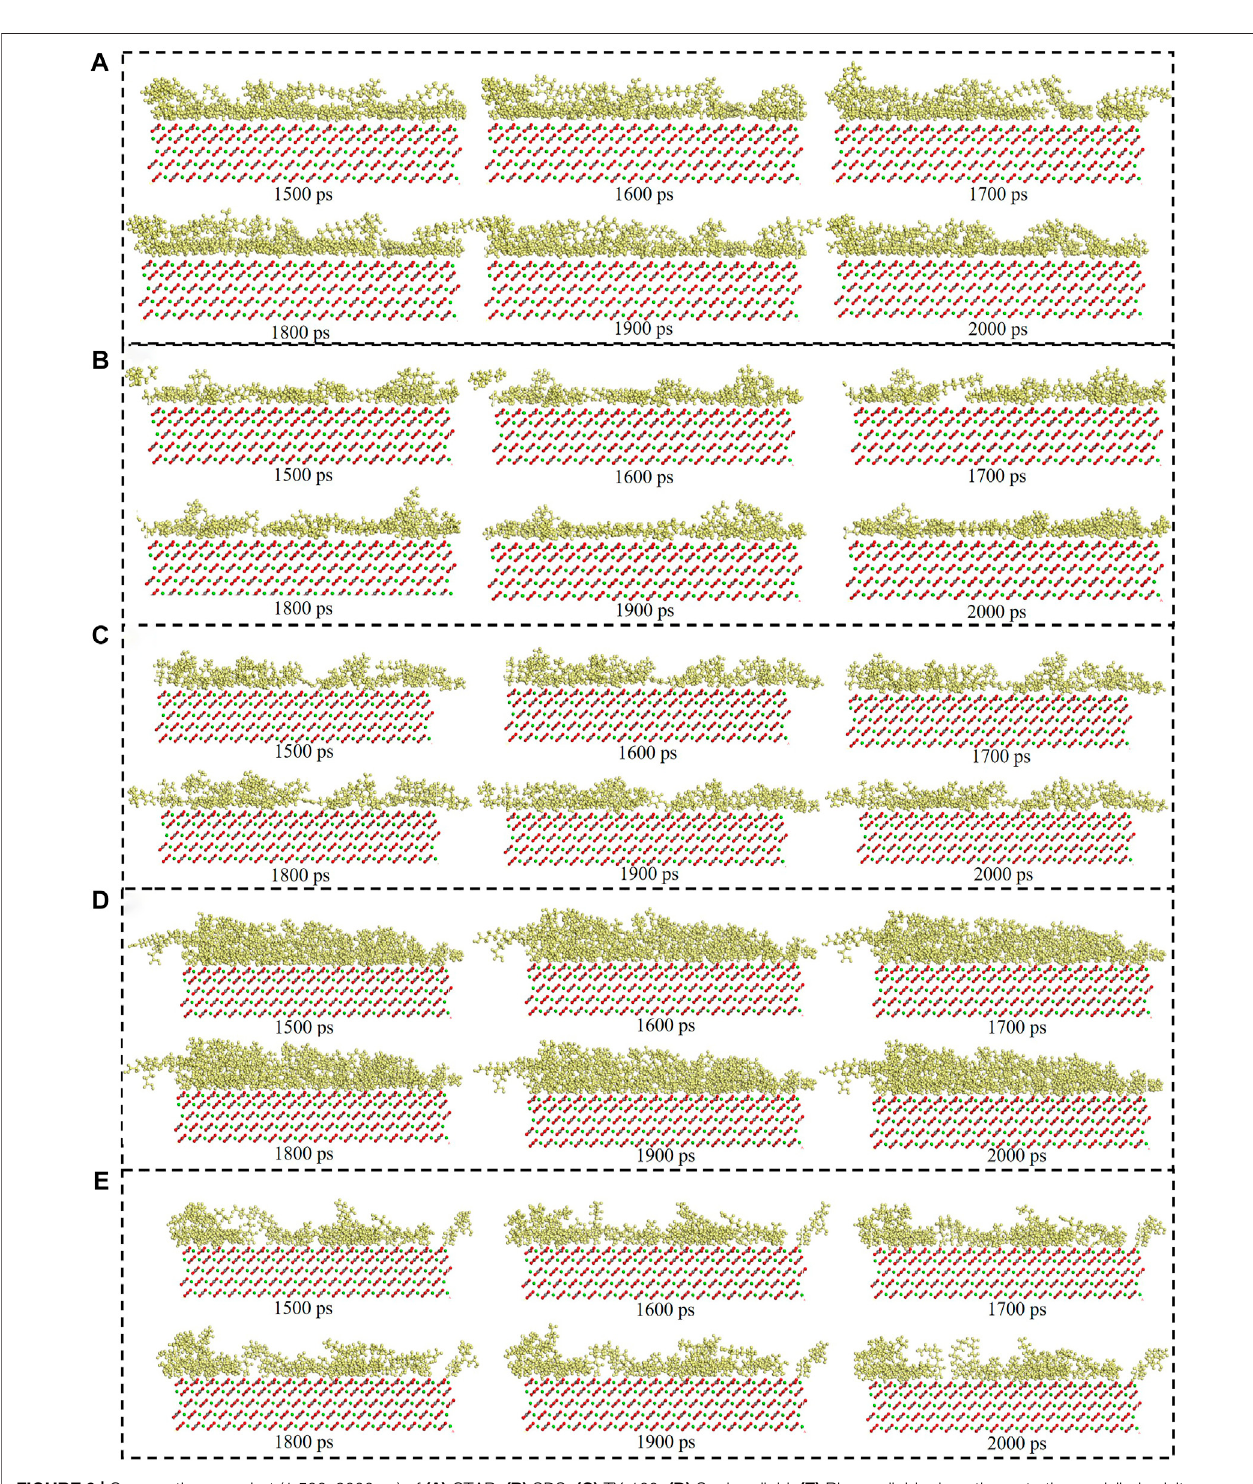
FIGURE 9 | Consecutive snapshot (1,500 – 2000 ps) of (A) CTAB, (B) SDS, (C) TX-100, (D) Sophorolipid, (E) Rhamnolipid adsorption onto the modelled calcite surface. yellow = surfactants, red and grey = CO 3 2- , green = Ca 2+ , red, grey and green = calcite surface.